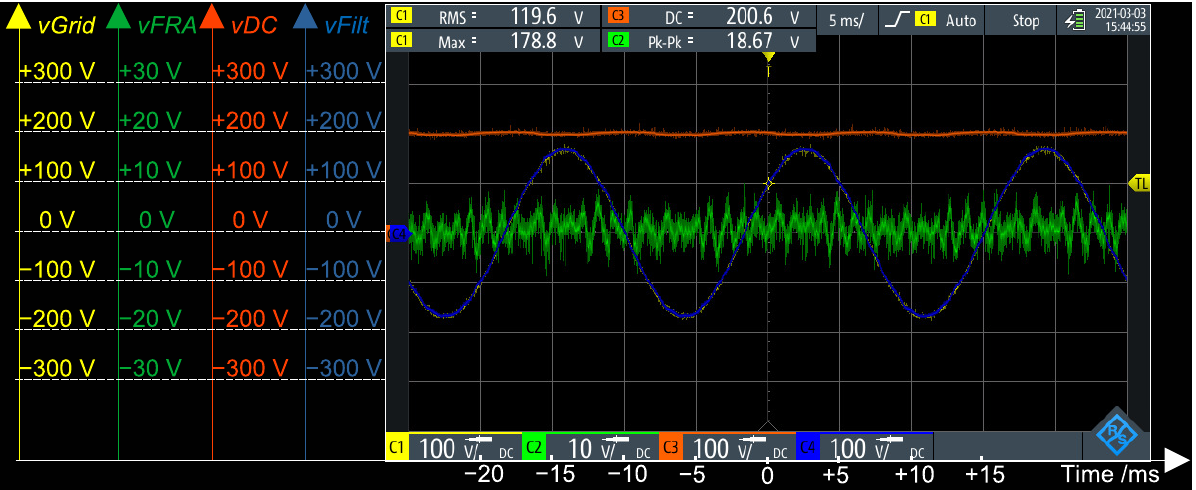
Figure 13. Operation of the active voltage blocker.